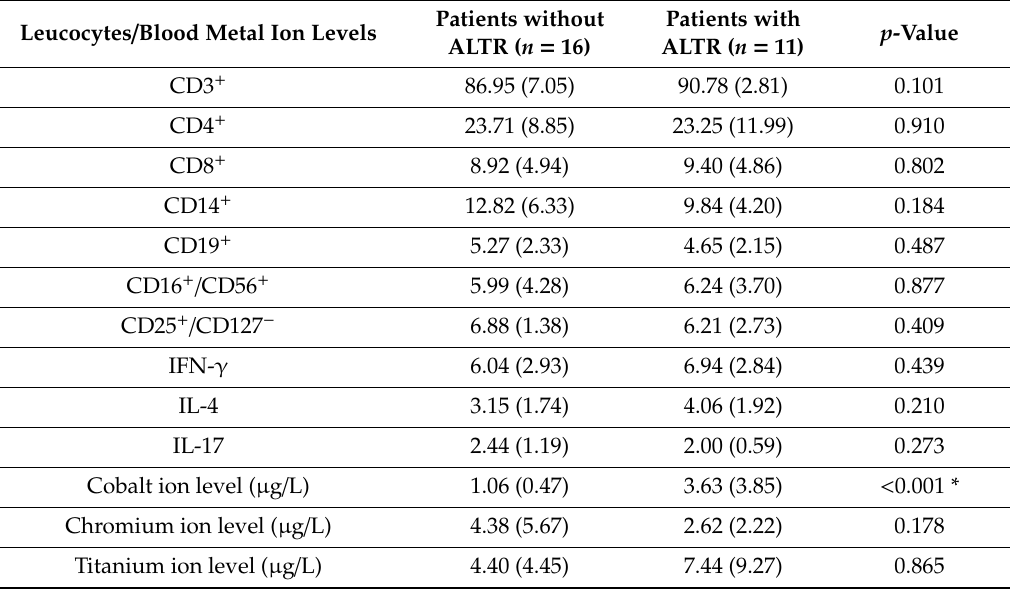
Table 5. Comparison of leucocyte cell counts and metal ion levels between patients without ALTR and patients with ALTR (the values are given in percentages, as frequency of